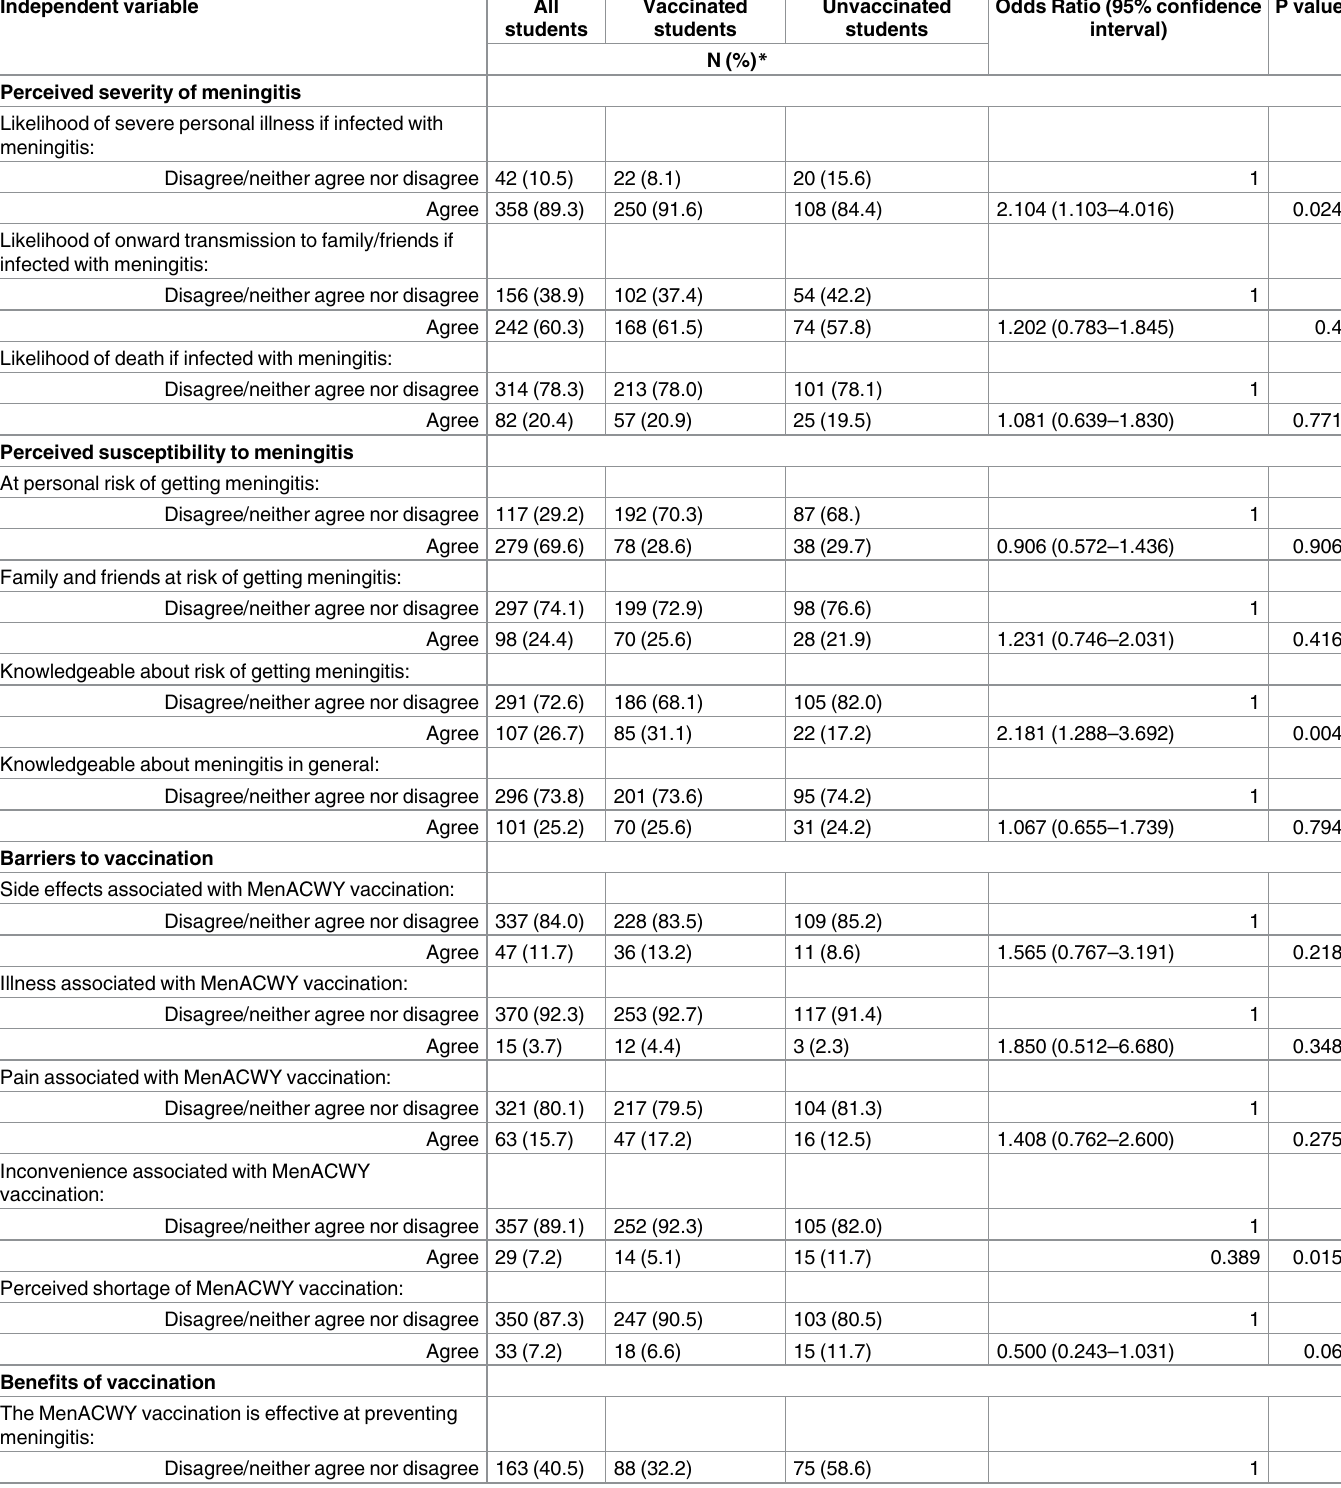
Table 3. Health beliefs of study participants and results of univariable regression analysis of associations between demographic variables and vaccination. Independent